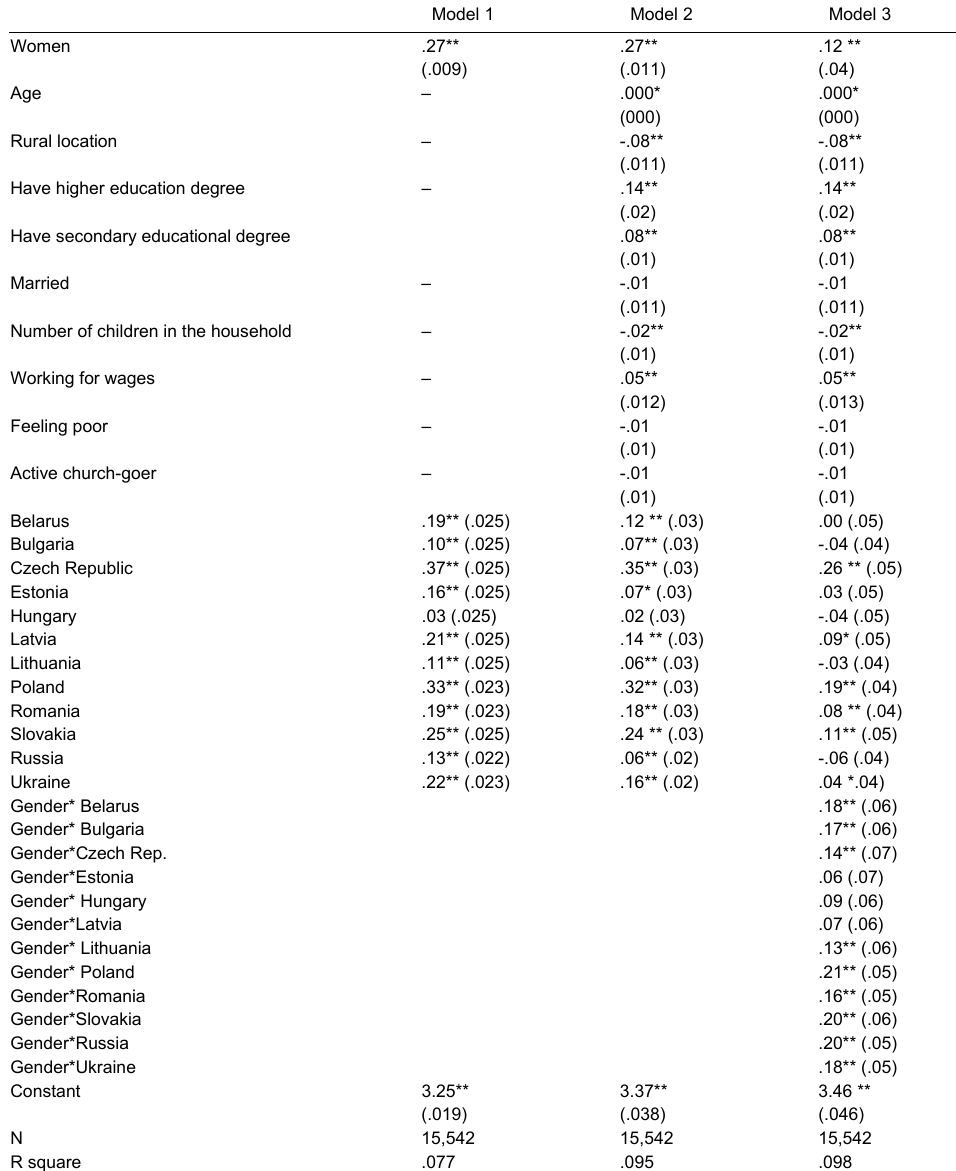
Table 3. Linear regression coefficients and standard errors predicting liberal gender role opinions, 13 post-state socialist societies,